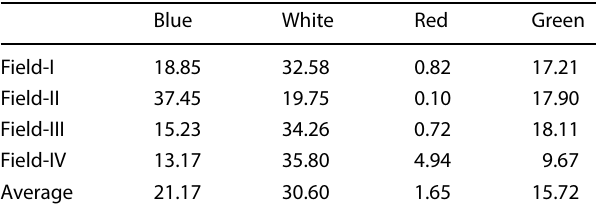
Table 8 Percentage match between the 1st choice of colour selec- tion and the 1st colour of the ideal sequence for resolution only (for Q2) For, the sharpness of the borders of cells (Q2), percentage resolu- tion match for Blue White